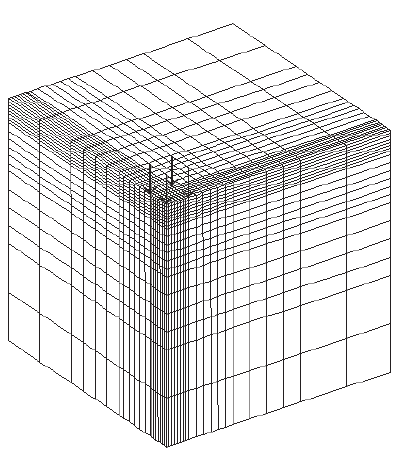
Figure 1: The 20 × 20 × 20 finite element mesh of the flexible